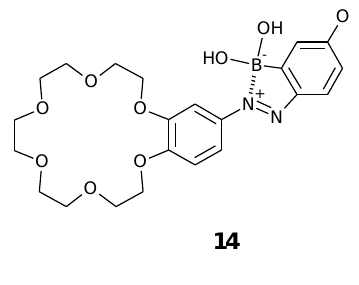
Figure 15. Chemical structure of dye 14